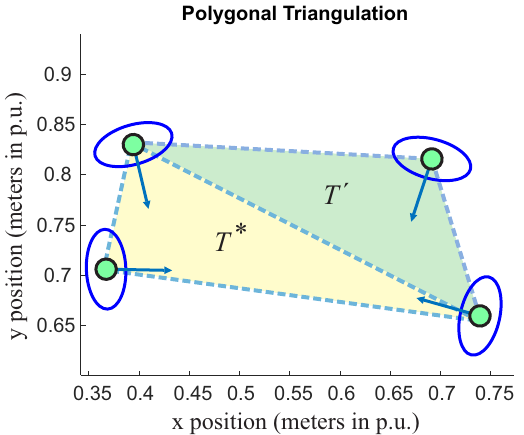
Figure 7. Group classification including a peripheral triangle. The yellow triangle is related here to the reference ( T ∗ ), while the green triangle is the peripheral one ( T (cid:48) ) for group